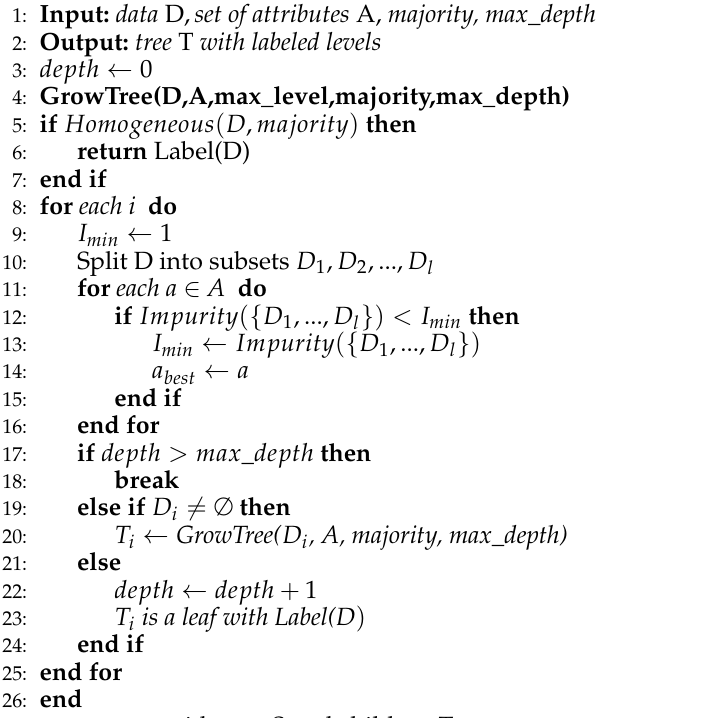
Algorithm 1 Classification Tree